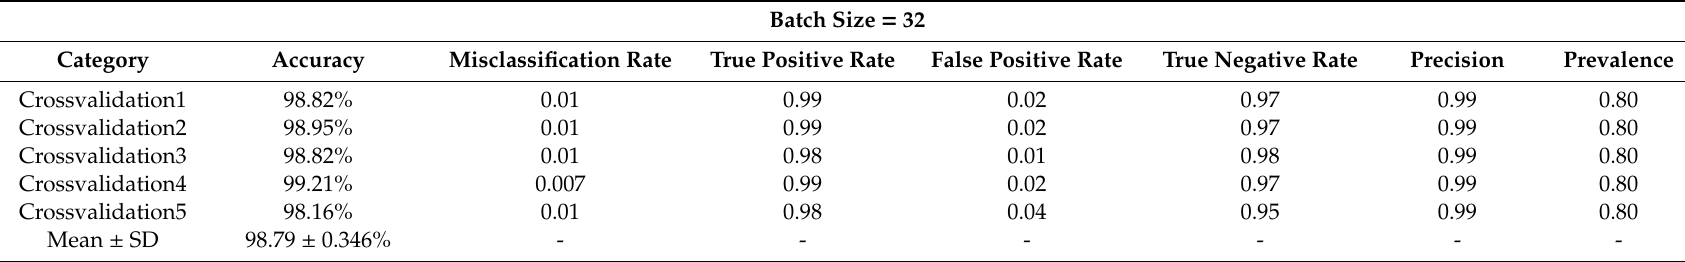
Table 3. Accuracy, misclassification rate, true positive rate, false positive rate, true negative rate, precision, prevalence, mean and standard deviation of accuracy for a batch size of